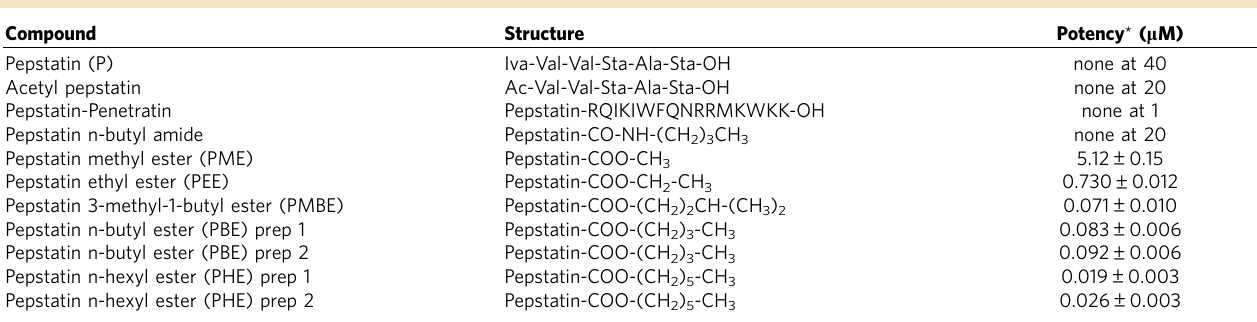
EC 50 s of pepstatin and analogues against 3D7 asexual stage parasites measured using a flow cytometry-based assay. Inhibition data were fit to a sigmoidal concentration-response curve using the least squares fit function and without outlier elimination ± are standard errors. n ¼ 2–5 (biological replicates performed in triplicate for each experiment). *Potency—where appropriate, potency is presented as EC 50 . For inactive compounds, inhibition at highest concentration is presented.